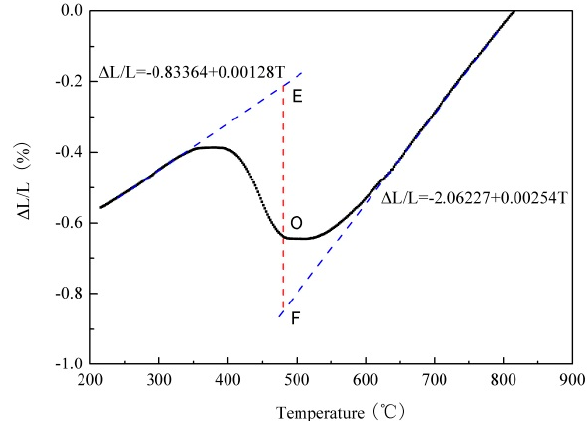
Figure 3. Change of relative radial expansion Δ L / L with temperature of slab under a continuous cooling rate of 10 °C/s.